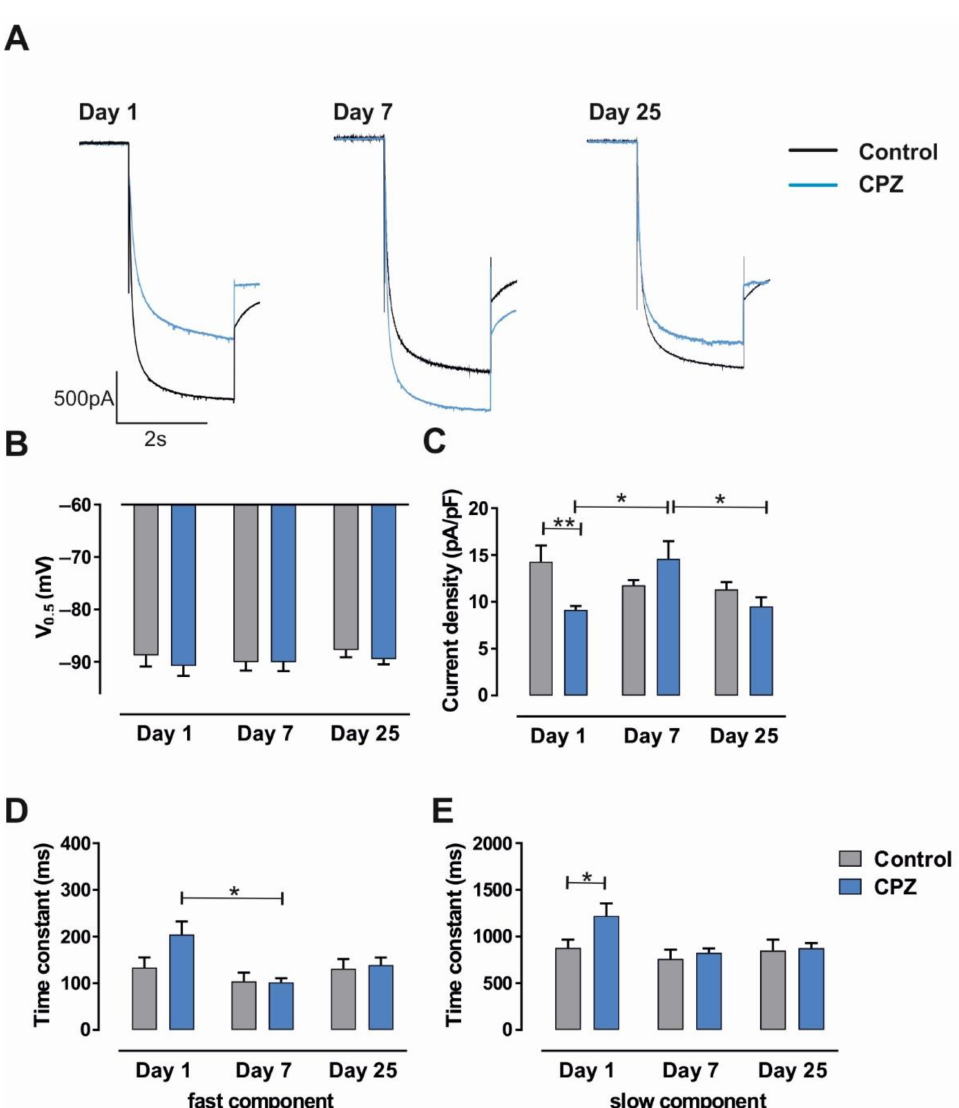
Figure 3. The impact of CPZ-induced de- and remyelination on I h properties in TC VB neurons. ( A ) Exemplary traces of I h current recorded in TC VB neurons on Day1, Day7, and Day25 of remyeli- nation after CPZ-treatment (blue) and an age-matched control of Day1 (black). For clarity, only the hyperpolarizing step from − 40 mV to − 130 mV is shown. ( B – E ) Bar graphs displaying V 0.5 ( B ), current density ( C ) and both fast ( D ) and slow ( E ) components of activation kinetics for CPZ-treated mice (blue) and age-matched controls (grey) for the indicated experimental days. * and **, indicate p values less than 0.05 and 0.01,